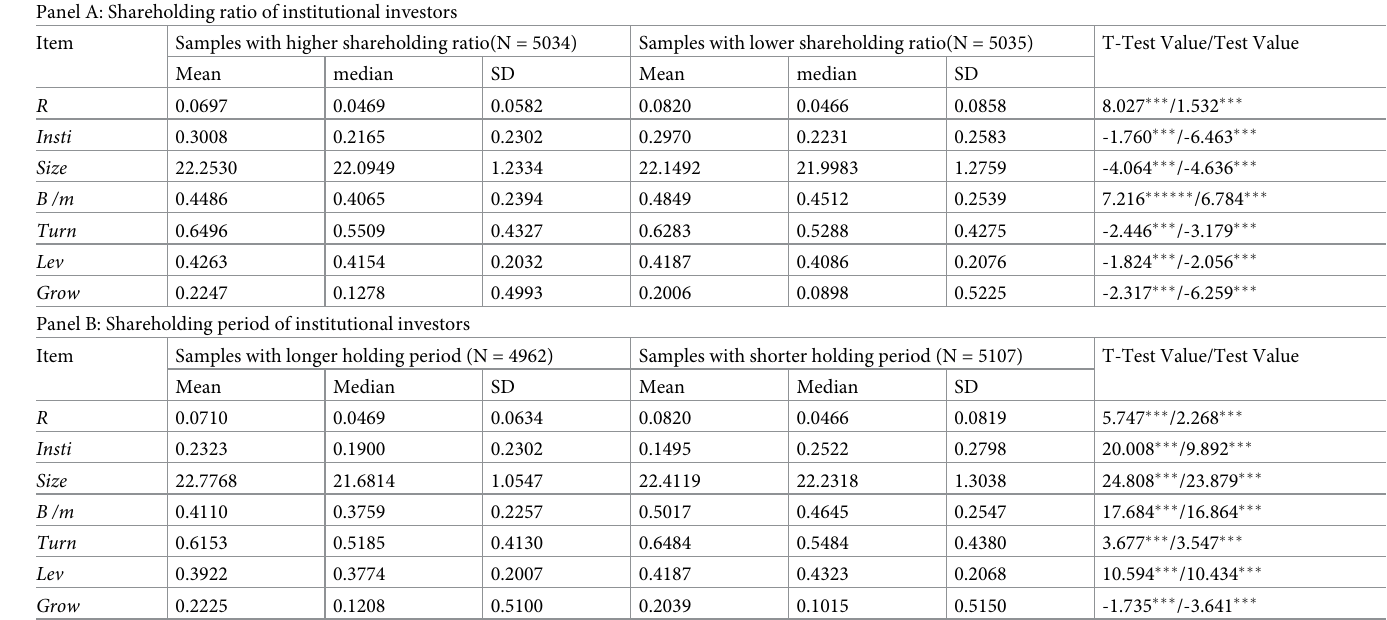
Table 2. Analysis results of the main variables in different groups. Panel A: Shareholding ratio of institutional investors Item Samples with higher shareholding ratio(N = 5034) Samples with lower shareholding ratio(N = 5035)